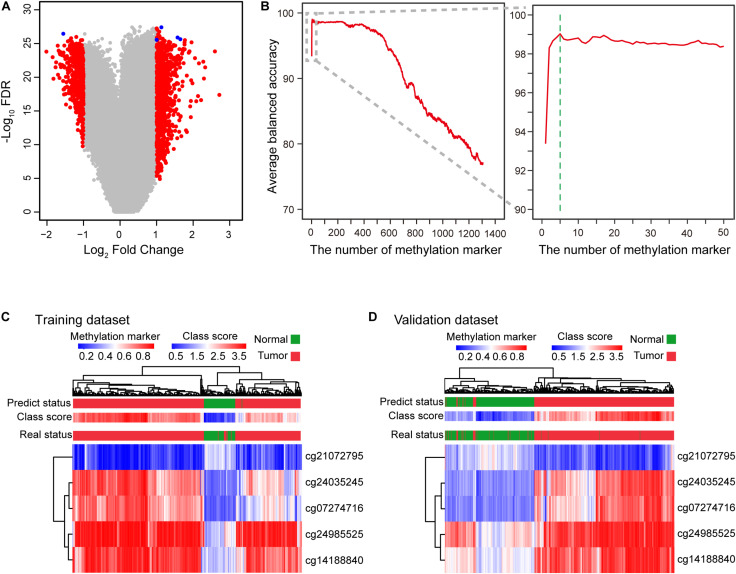
Construction of the diagnostic signature consisting of five DNA methylation markers. (A) Five DNA methylation markers were selected to construct the diagnostic signature. Volcano plot showing the biological significance (log2 fold change (FC)) on the X axis and the corresponding statistical significance (−log10 false discovery rate (FDR)) on the Y axis of markers between HCC patients and normal controls. A total of 1306 candidate markers (red and blue) were initially selected, with five markers (blue) finally selected to construct the diagnostic signature. (B) Curve of average balanced accuracy with increasing number of methylation markers. The green dotted line indicates that the diagnostic signature with five DNA methylation markers has the highest average balanced accuracy for sampling 100 times. (C,D) Heatmap of five DNA methylation markers selected to construct the diagnostic signature for the training (TCGA) (C) and validation (D) datasets (GSE54503, GSE56588, GSE60753, GSE75041, GSE77269, and GSE89852).